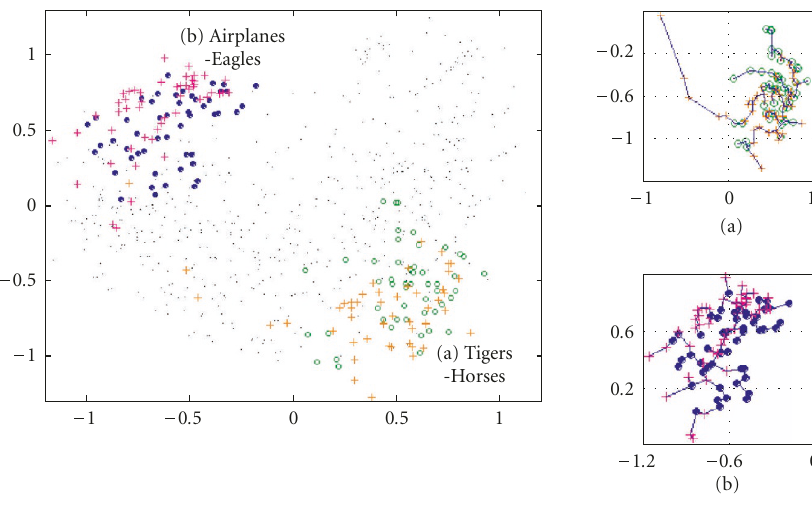
Figure 8: Left: MDS-based approximation of the perceptual space for a machine-vision system (see Section 3.3). Right: measuring class separability using WW -test, (a) Tigers versus Horses ( W = − 1 . 4098), (b) Airplanes versus Eagles ( W = − 1 .